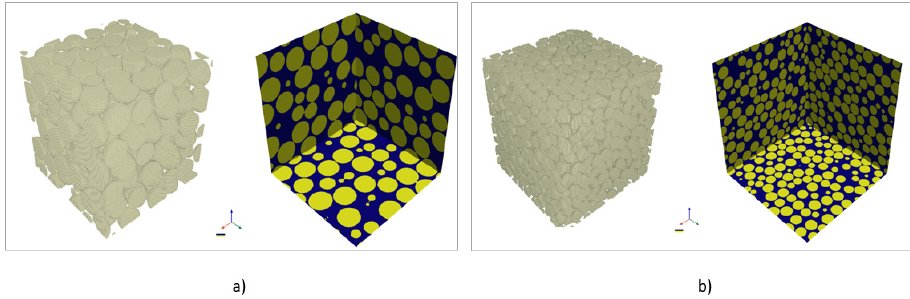
Figure 10. ( a ) Digital rock with 256 samples. ( b ) Digital rock with 480 samples [19].